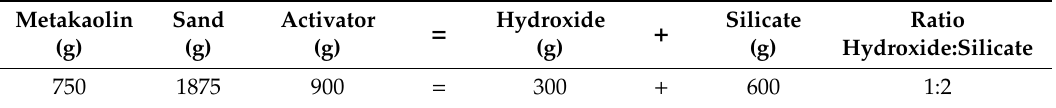
Table 2. Composition of the Base Mix of the geopolymers.